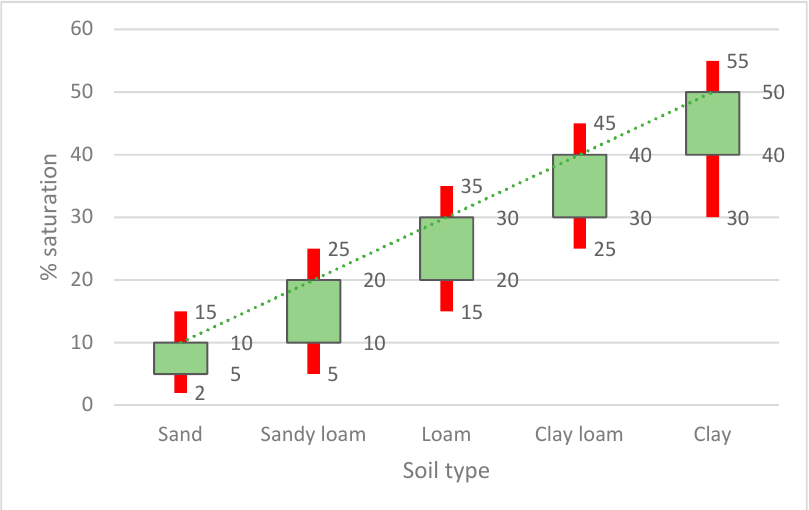
Figure 2. The optimal range of saturation percentage for each type of soil, to guarantee plant survival, is represented by the rectangular boxes; instead, the values indicated as a line generate stress in plants. Table 4. Properties of cultivated soil (sandy loam, loam, clay loam) related to saturation percentage of pores.